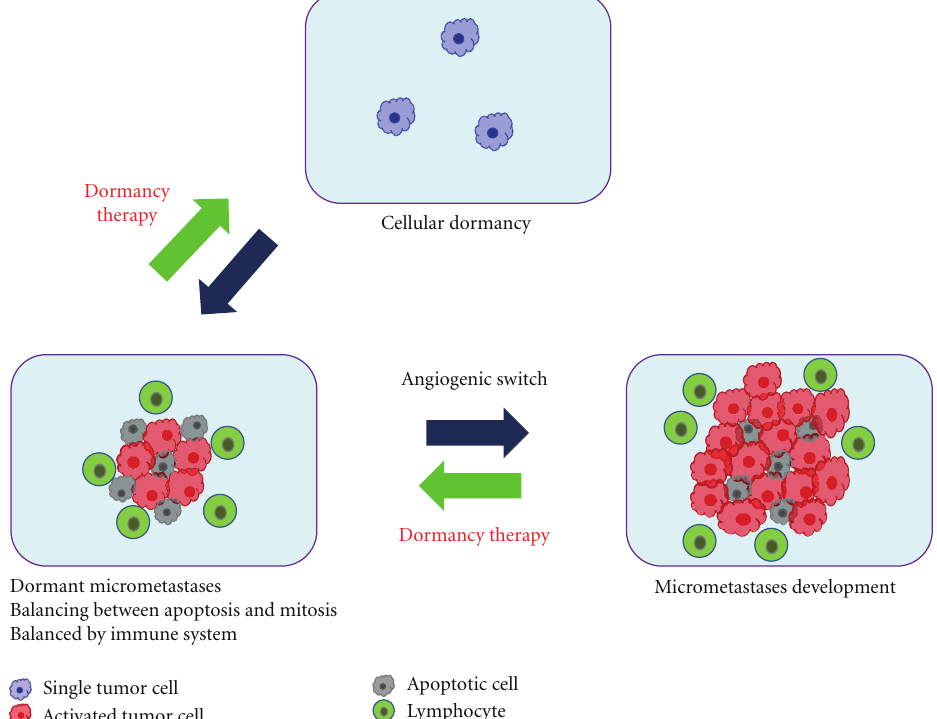
Figure 2: Tumor metastasis dormancy is associated with the risk of recurrence of OS and late development of lung metastases. Tumor dormancy is thought to consist of tumor mass dormancy (dormant micrometastases) and cellular dormancy. In tumor mass dormancy (dormant micrometastases), tumor cells generally divide but not in cellular dormancy. The tumor growth is strictly limited by the lack of blood supply or immune system. Dormant state of micrometastases is involved in angiogenic switch and/or the adaptive immune system. Dormancy therapy could contribute to improve the treatment of patients with